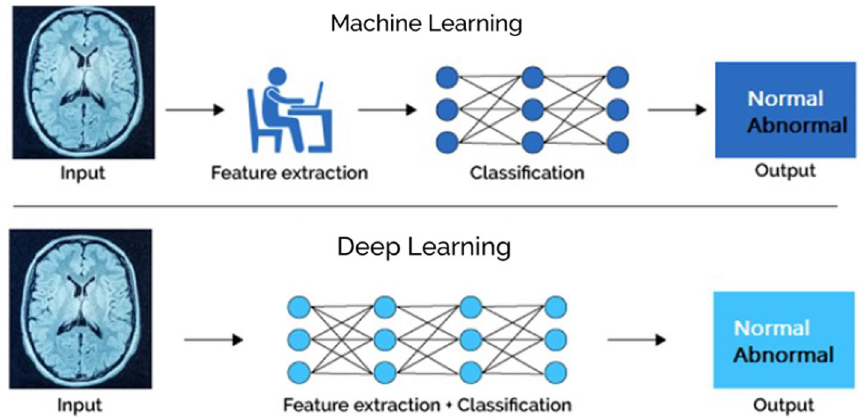
Fig. 1 The difference between DL and traditional